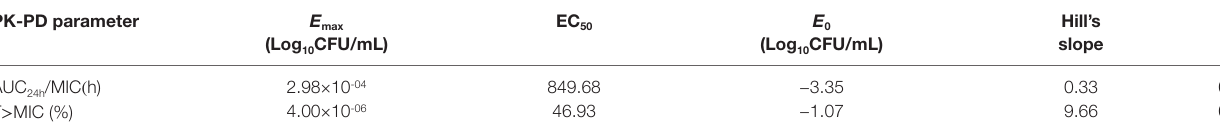
TABLE 4 | The PK/PD parameter estimation, and the data are derived from E max model. PK-PD